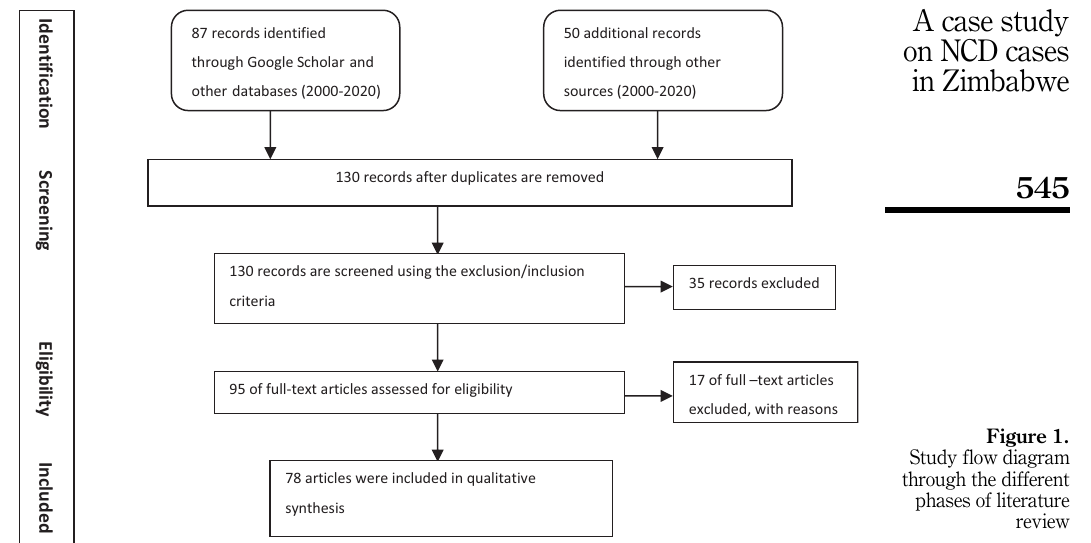
Figure 1. Study flow diagram through the different phases of